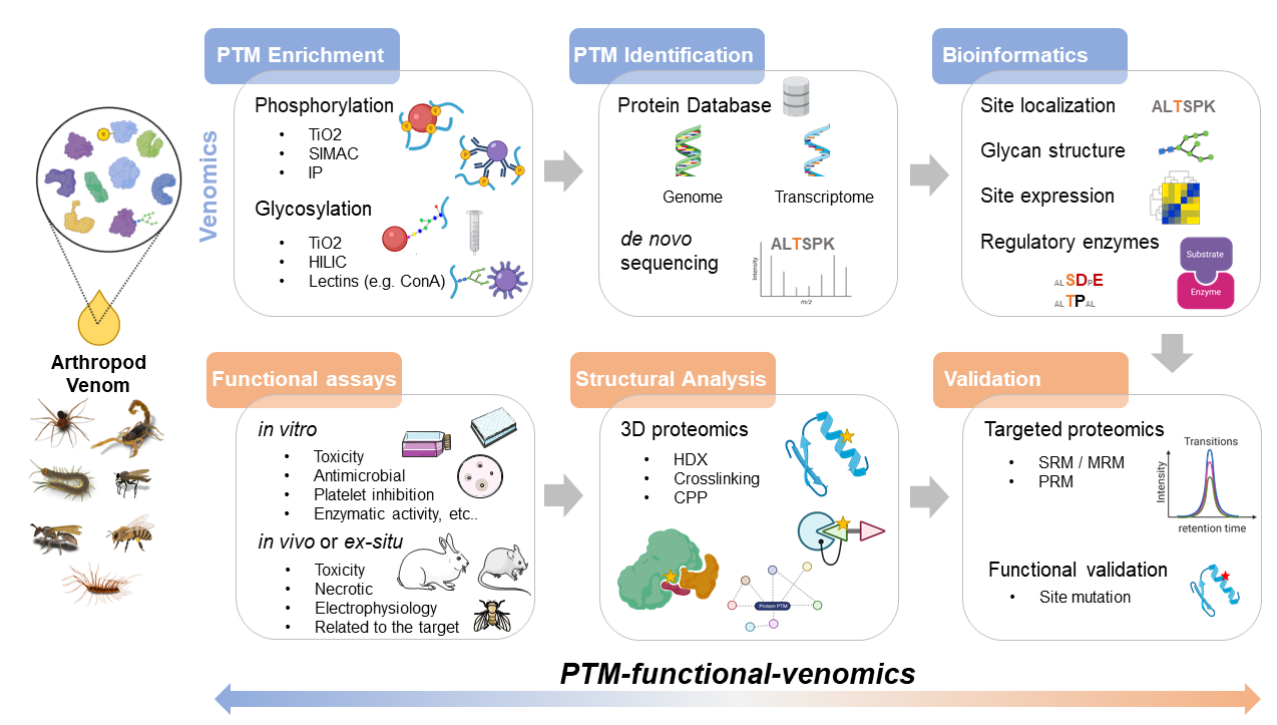
Figure 4. PTM-functional venomics. General strategies based on venomics studies on protein phosphorylation and glycosylation and the integration with functional assays and structural proteomics to investigate PTM biological/functional impact on venom activities. Target proteomics and site mutation can be performed to validate PTM assignment and PTM function, respectively. HDX: hydrogen/deuterium exchange; CPP: covalent protein painting; SRM: selected reaction monitoring; MRM: multiple reaction monitoring; PRM: parallel reaction monitoring. Figure created with elements from BioRender.com and Servier Medical